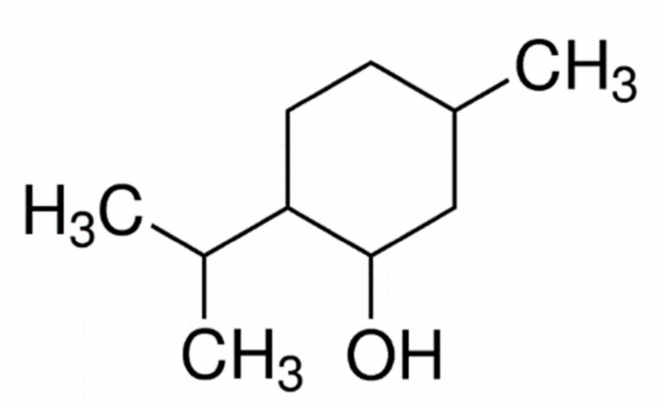
Figure 2. Chemical structure of